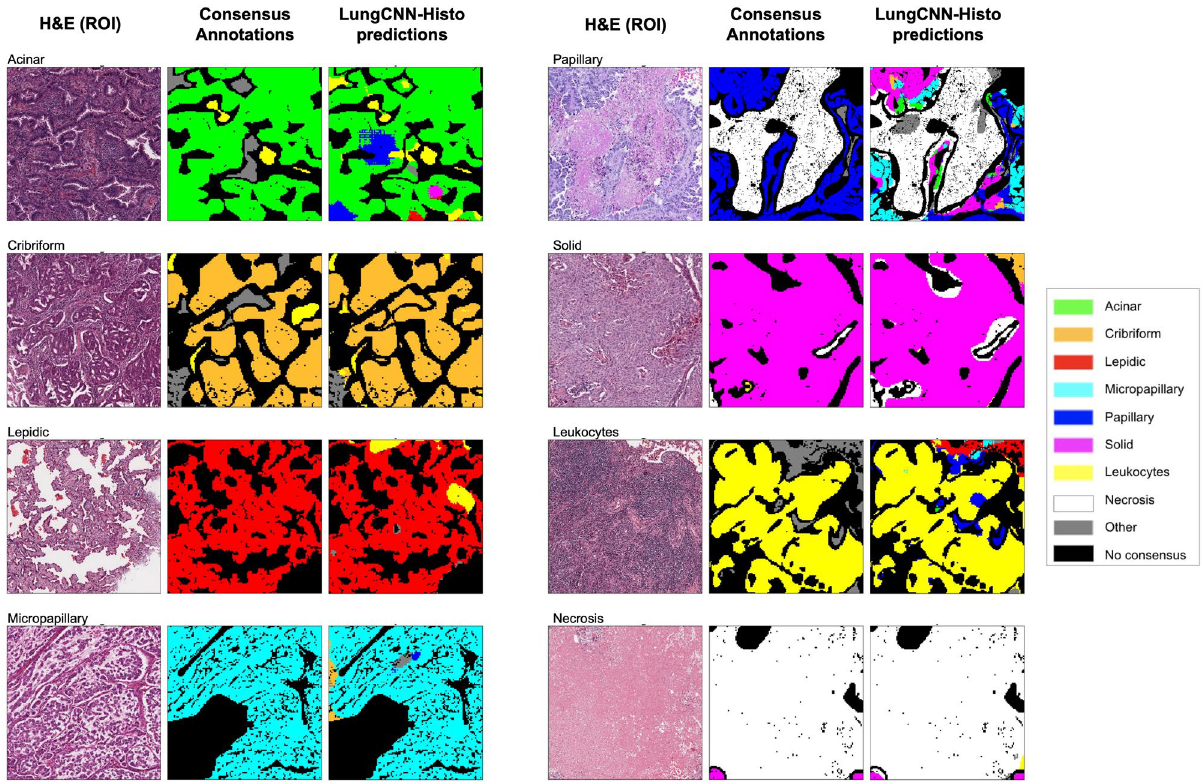
Figure 3. Visualization of LungCNN-Histo predictions for annotated regions. Shown are representative regions of interest (1 mm × 1 mm) for regions with predominance of each of the feature classes (see legend). Black regions represent areas of tissue where there was lack of consensus for the three pathologist annotations. Middle columns for each panel represent consensus pathologist annotations and the right panel depicts the model classification across patches (with the non-consensus patches masked in black to match for easier visual reference to the pathologist annotations.) H&E hematoxylin and eosin, ROIs regions of interest.